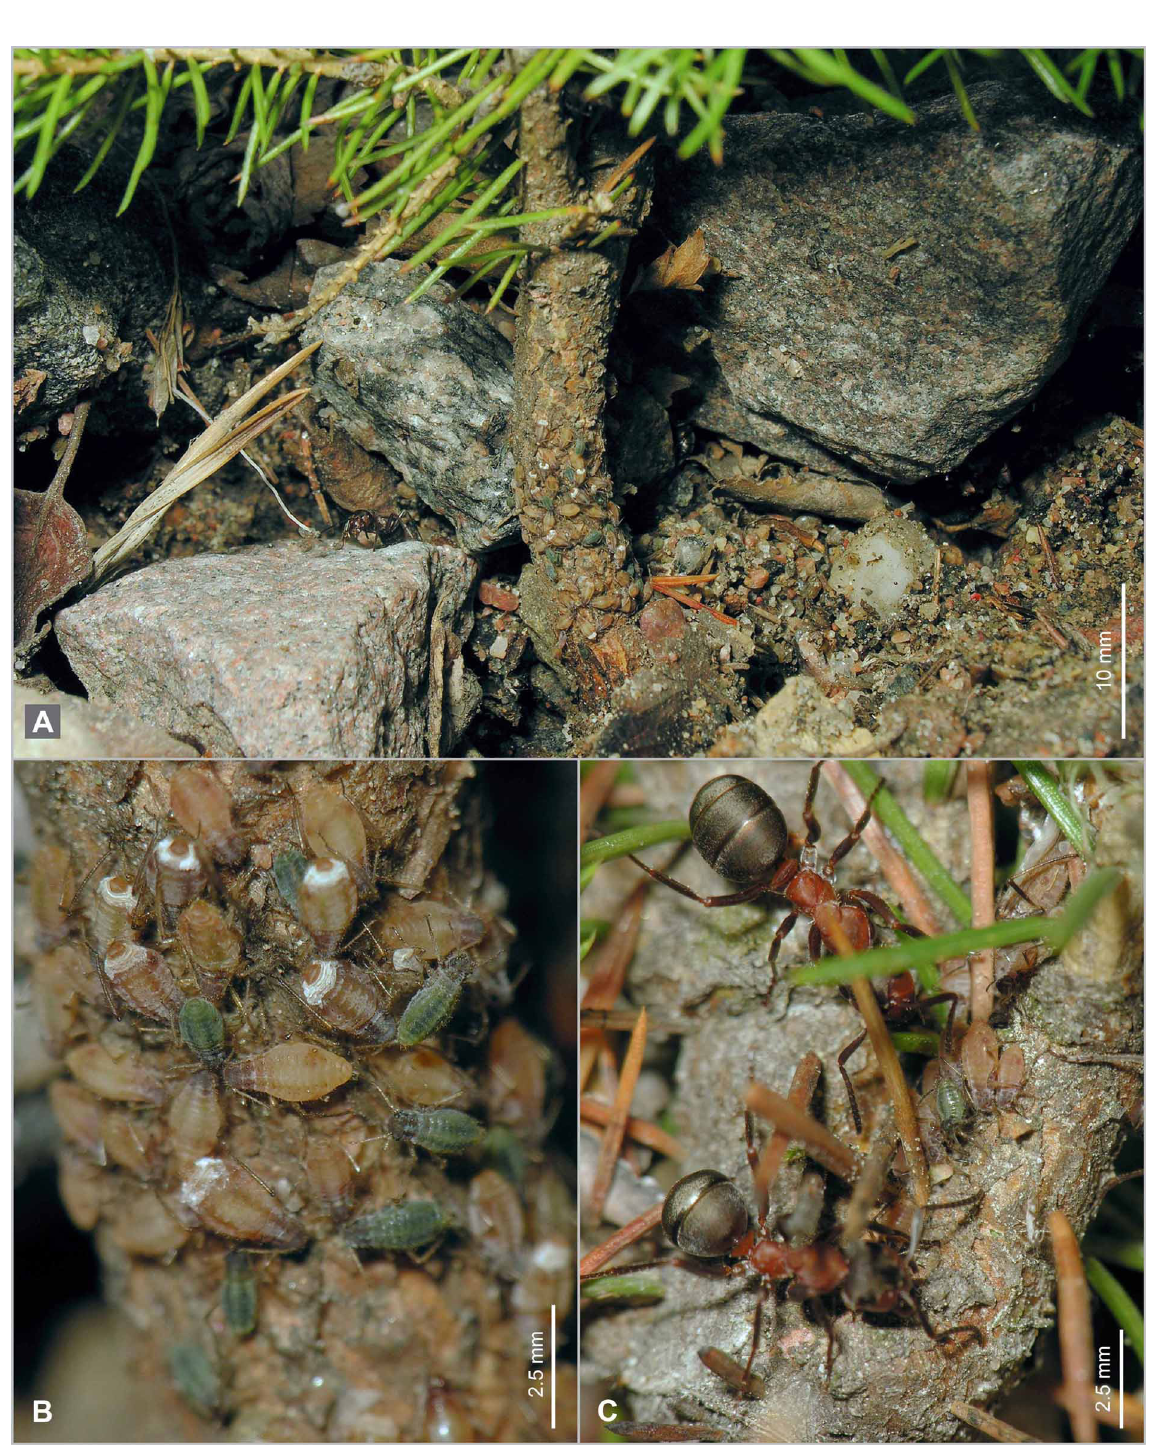
Fig. 39. Cinara (Cinara) piceicola (Cholodkovsky, 1896) on dwarfish Picea abies . A–B . Colony of apterae and oviparae among gravel at ground level. C . Apterae on stem, attended by Formica lugubris Zetterstedt,